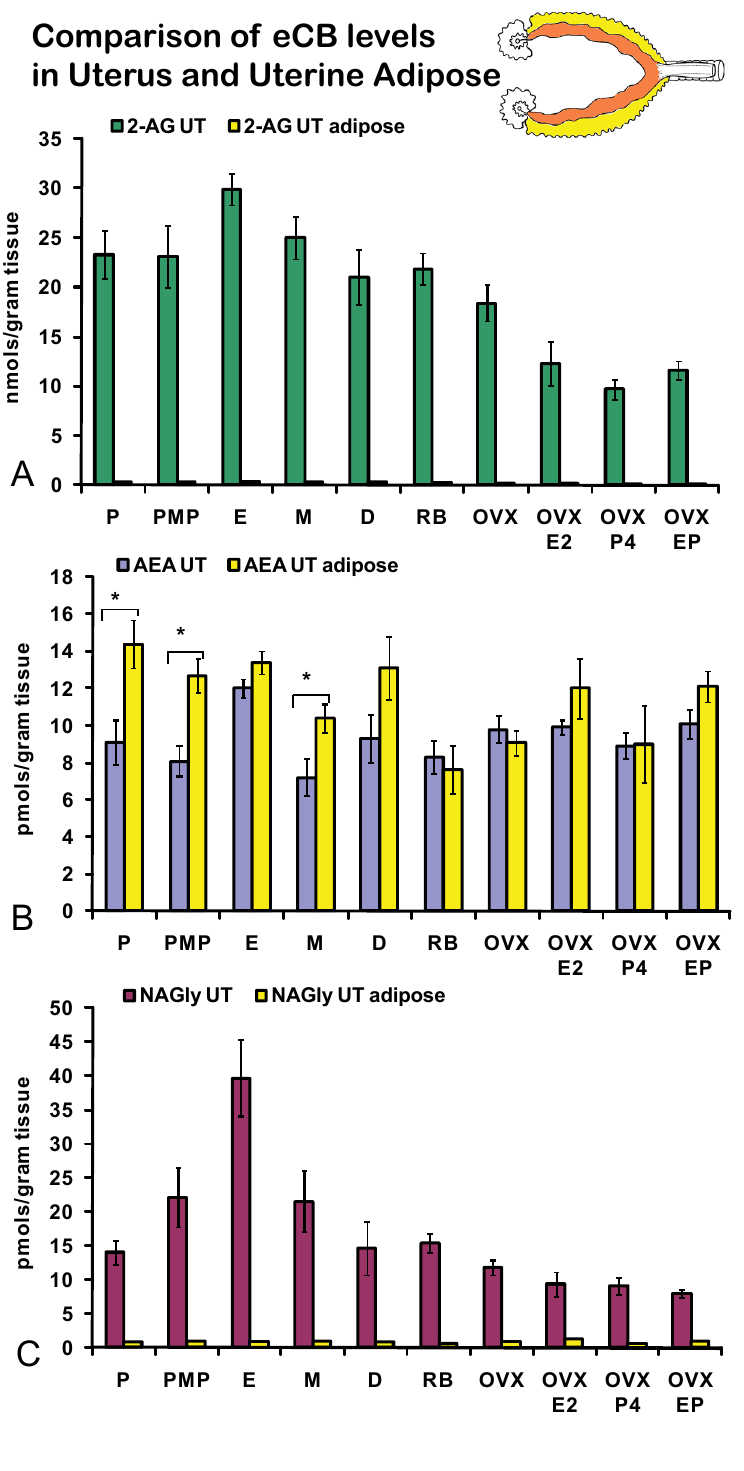
Figure 7. Comparisons of levels of eCBs in uterus and uterine adipose tissue . P = proestrus AM; PMP = proestrus PM; E = estrus; M = metestrus, D = diestrus; RB = anovulatory retired breeders; OVX = ovariectomy; E2 = 17 β estradiol; P4 = progesterone. * p ≤ 0.05 and represents comparisons across the hormonal cycle. All experimental groups had significantly higher levels of 2-AG and NAGly in the uterus compared to the uterine adipose tissue where p ≤ 0.05. *p ≤ 0.05 in comparisons of AEA between the tissue